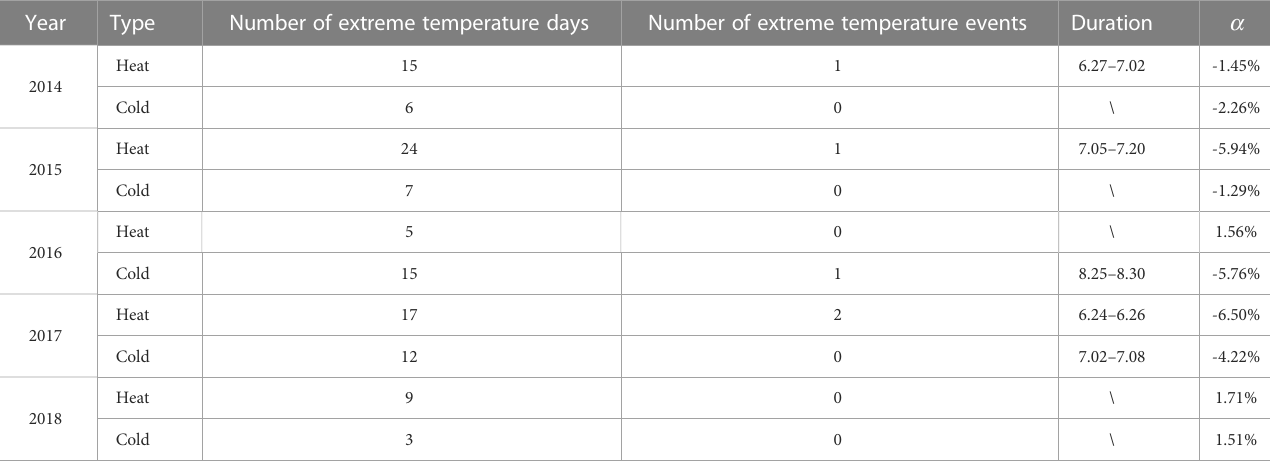
TABLE 4 Extreme temperature day/event and their effects on cumulative NEE (net ecosystem CO 2 exchange) during the growing season.